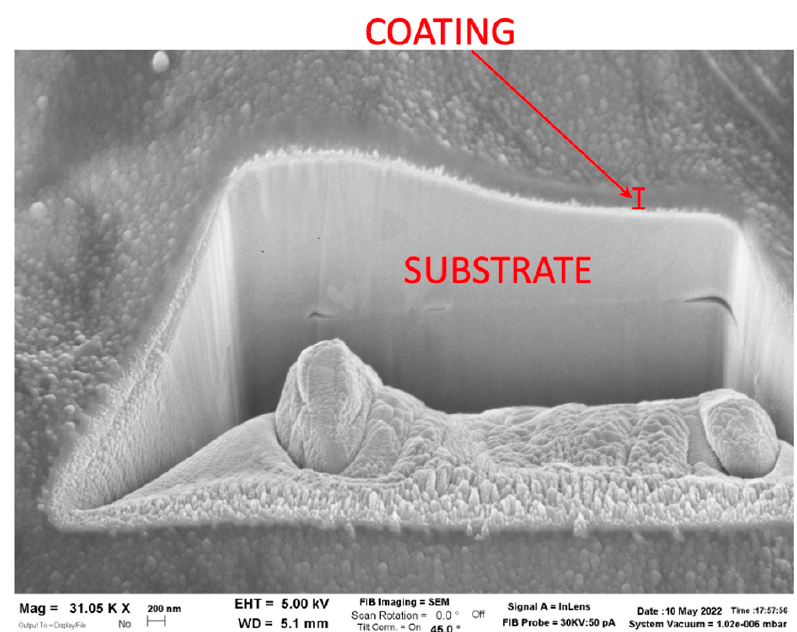
Figure 16. SEM image of cross-section obtained by FIB machining of surface textured with parallel lines scanning strategy at 12 W: Surf 4 sample (laser texturing + PE-CVD).